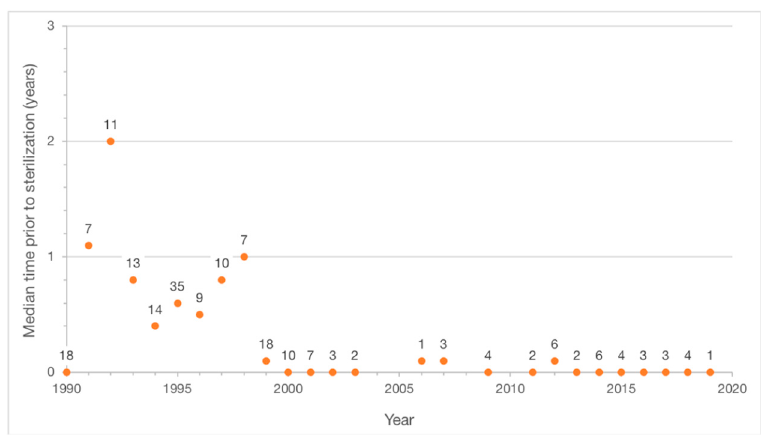
Figure 3. Amount of time between enrollment in a university campus TNR program and sterilization surgery during a 28 ‐ year observation period.